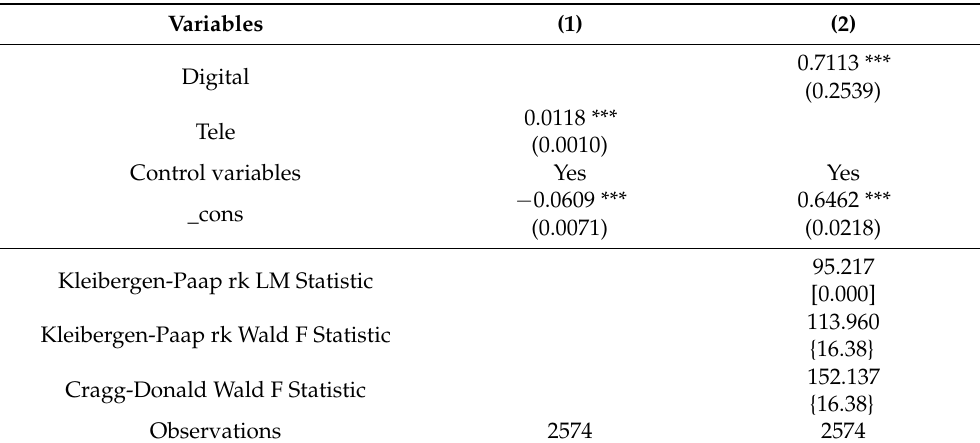
Table 5. Regression results of